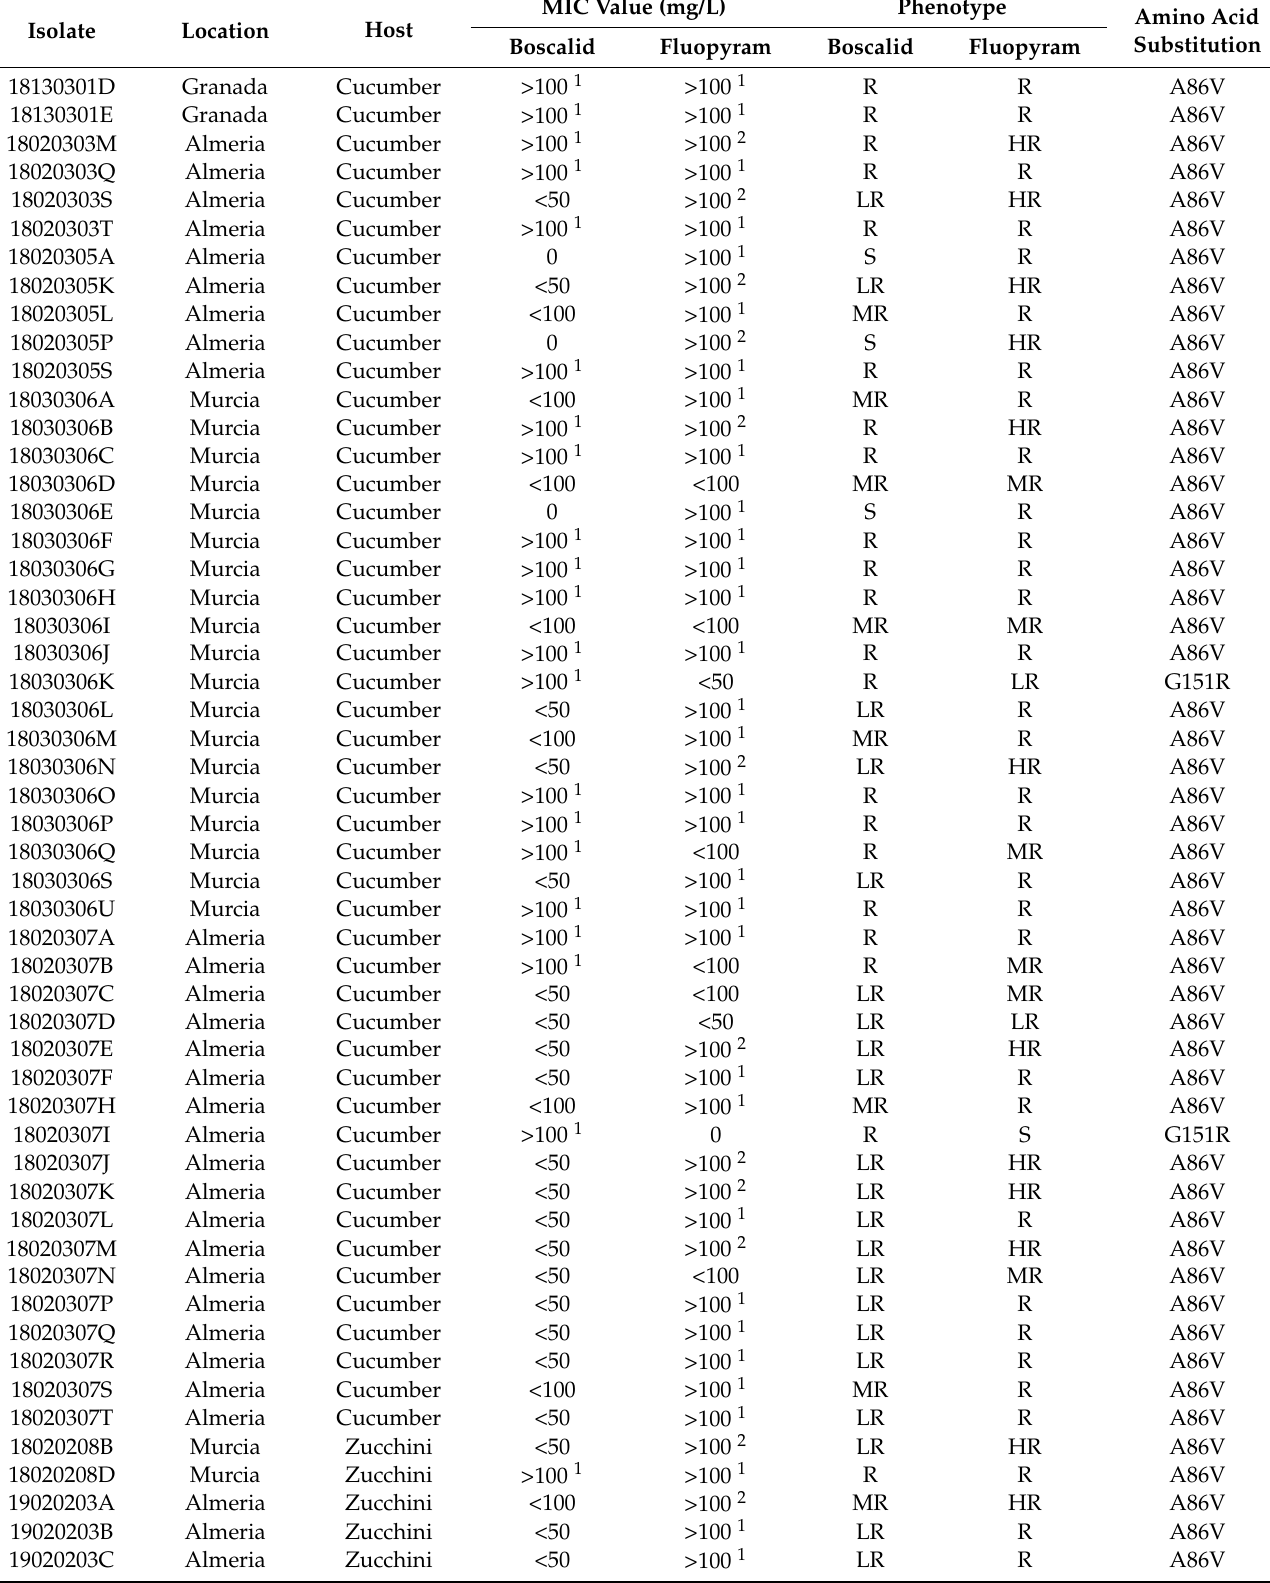
Table 5. Fluopyram and boscalid MIC values, phenotype, and amino acid substitution in the SdhC subunit in P. xanthii isolates collected during the 2018 and 2019 cucurbit growing seasons in